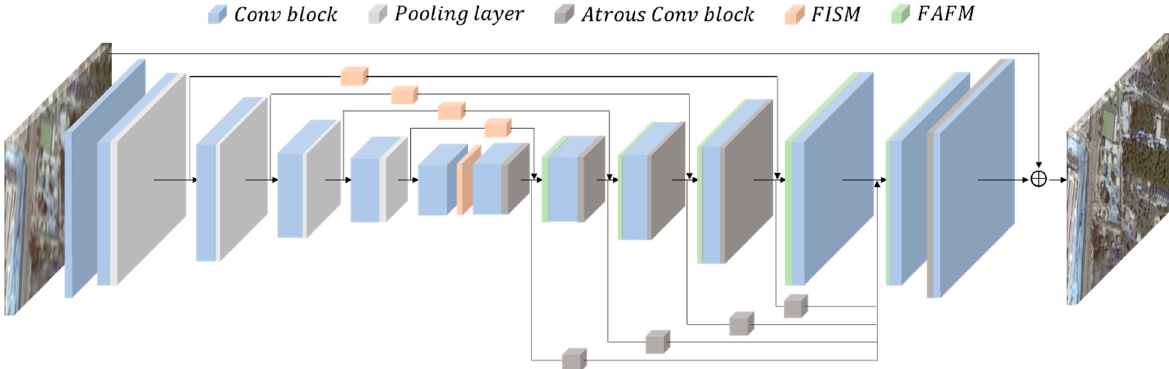
Figure 2. SDD-GAN generator structure diagram.